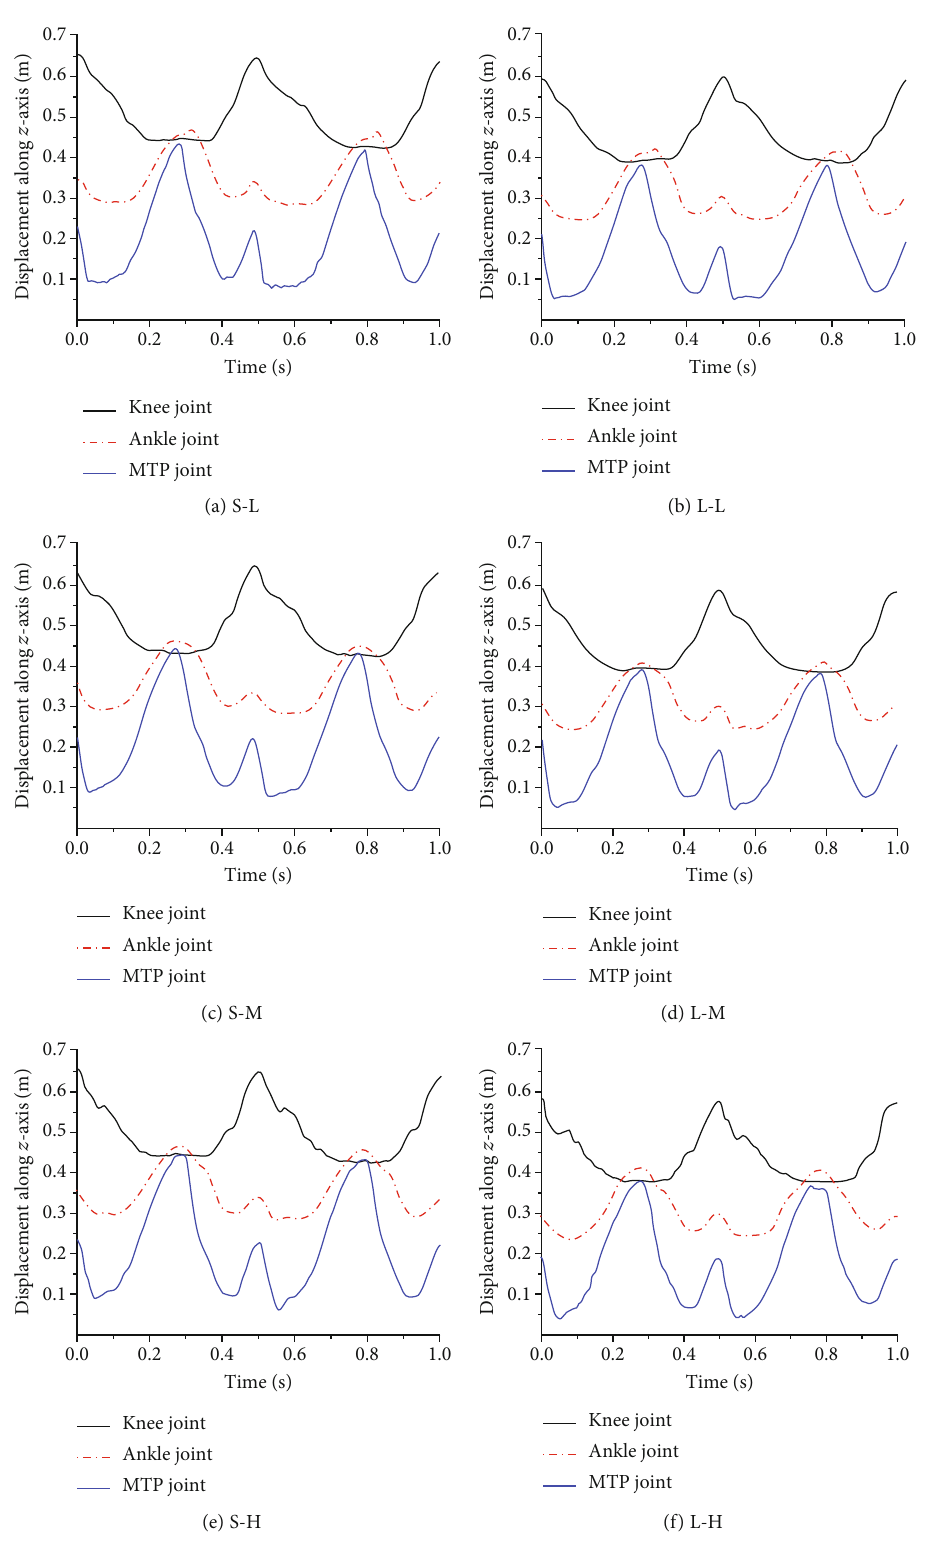
Figure 9: The displacement curve of the knee joint, ankle joint, and MTP joint along the z -axis. (a – f) The displacement changes of each joint along the z -axis under six working